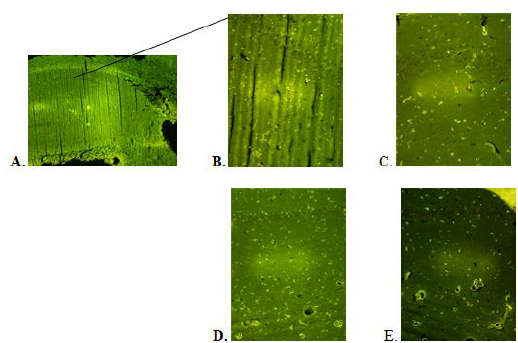
Figure 1. Mean time to find the platform. Data expressed Figure 1 . Mean time to find the platform. Data as mean ± SD of each group. *p<0.05 compared expressed as mean ± SD of each group. *p<0.05 to control group. compared to control group.